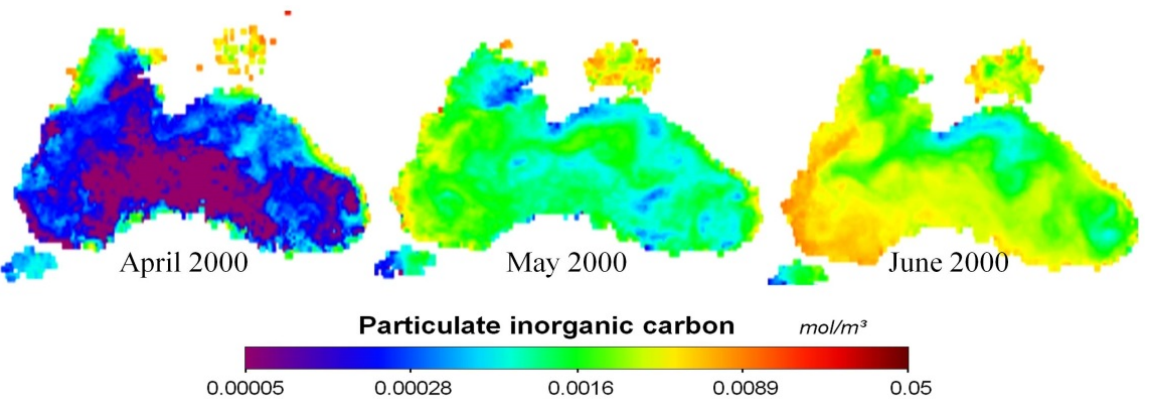
Figure 9. Growth of coccolithophores (PIC) in 2000 according to the MODIS-Aqua (monthly average values).